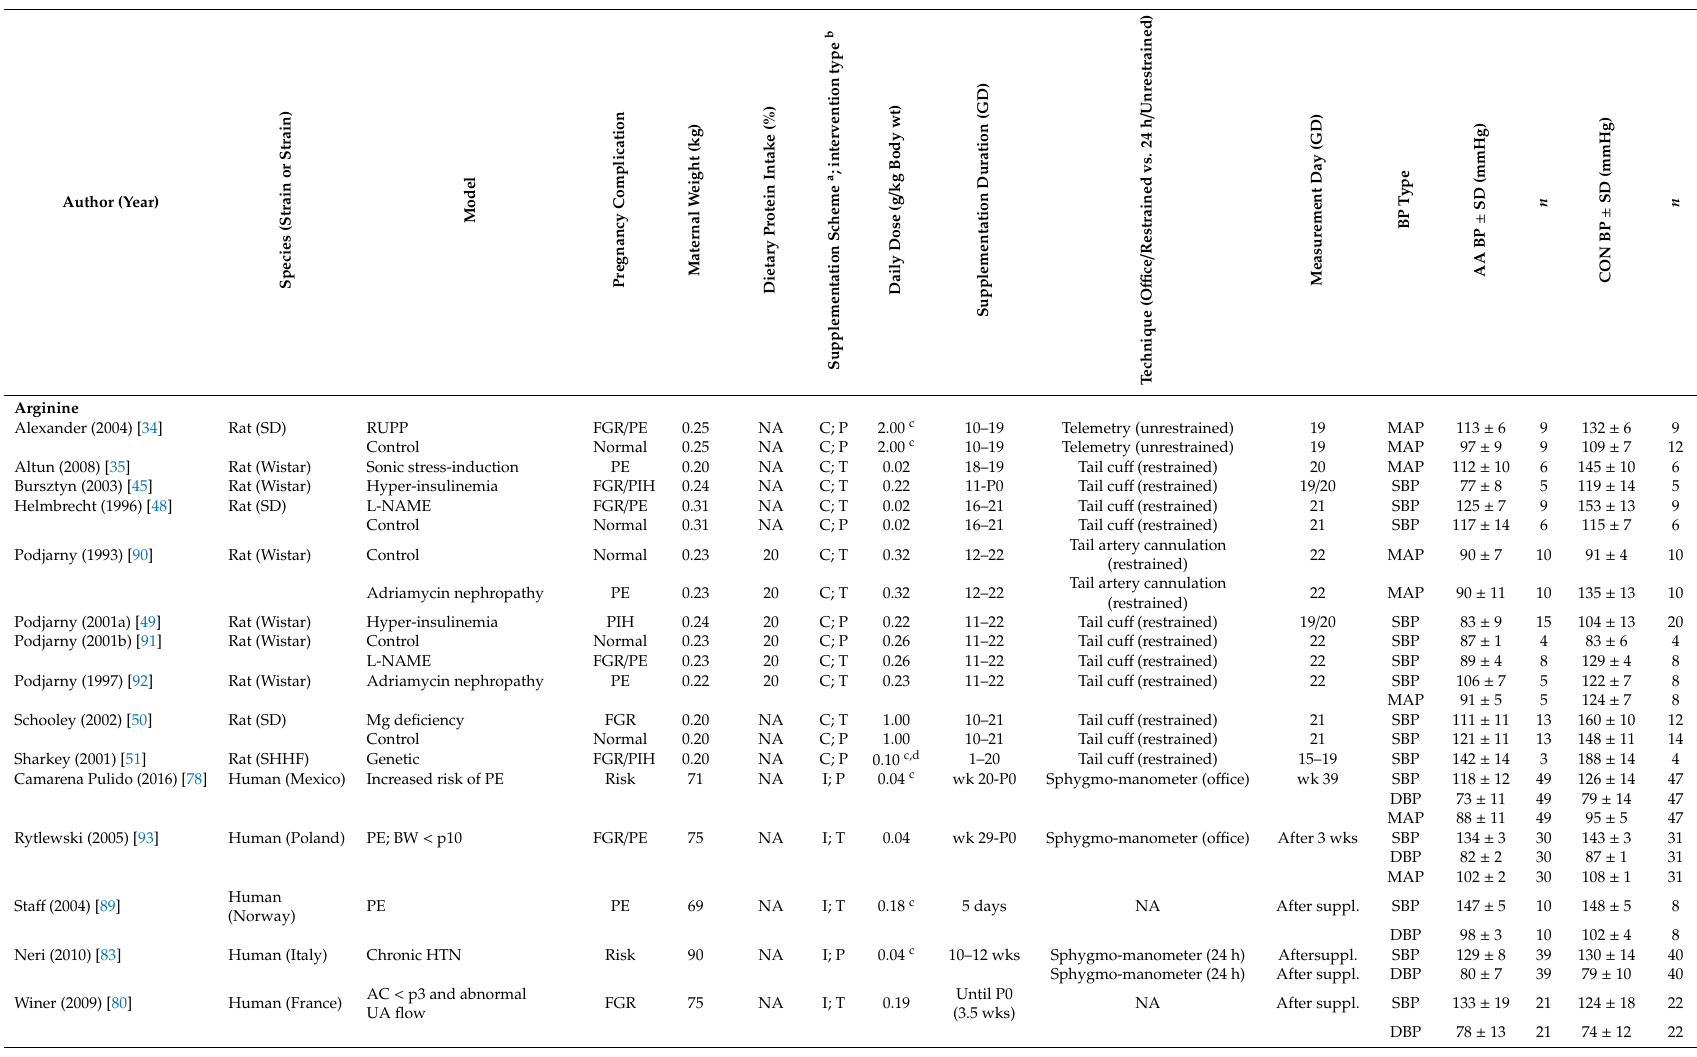
Table A6. Data extraction of included animal and human studies on maternal blood